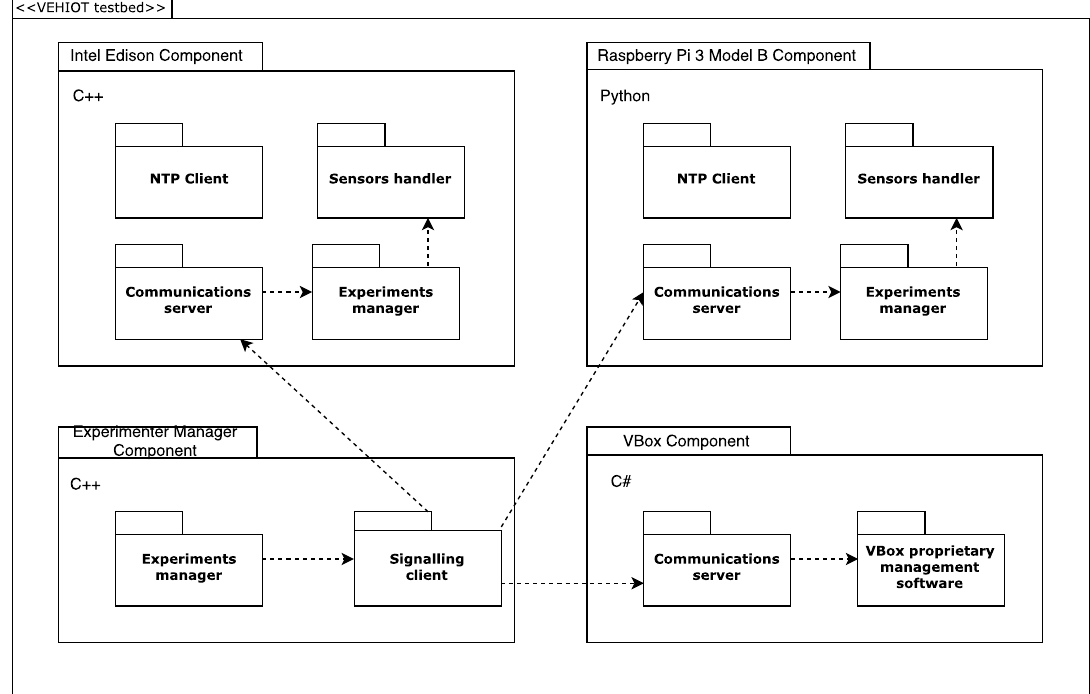
Figure 2. Testbed software